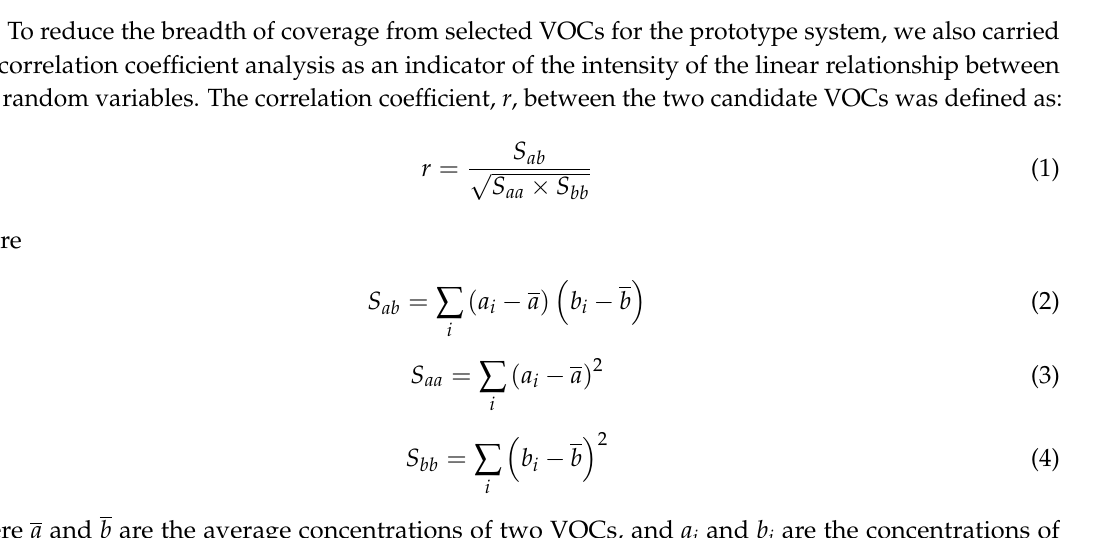
Figure 1. Average concentrations and confidence intervals (CIs) of 11 VOCs in exhaled air from LC, HC, and LC-S groups. For these 11 VOCs, the p value was less than 0.05 for differences between LC and HC groups and/or between LC and LC-S groups.